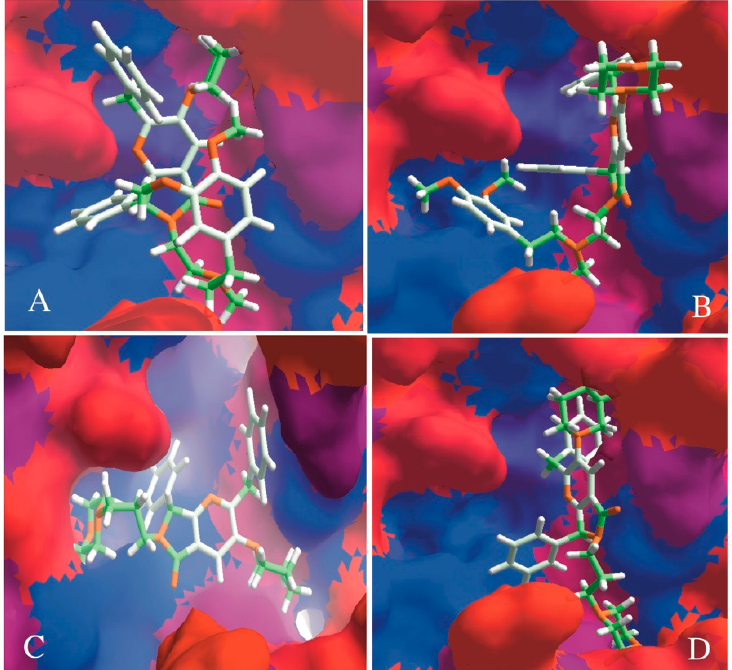
Figure 8. Hydrophobicity interactions between the αβ -tubulin with ( A ) 1l (enantiomer R), ( B ) 1l (enantiomer S), ( C ) 1h (enantiomer R), and ( D ) 1h (enantiomer S). Color key: The blue color depicts hydrophobic surfaces, the red color depicts hydrophilic surfaces, green sticks depict hydrophobic moieties, and orange sticks depict hydrophilic moieties.